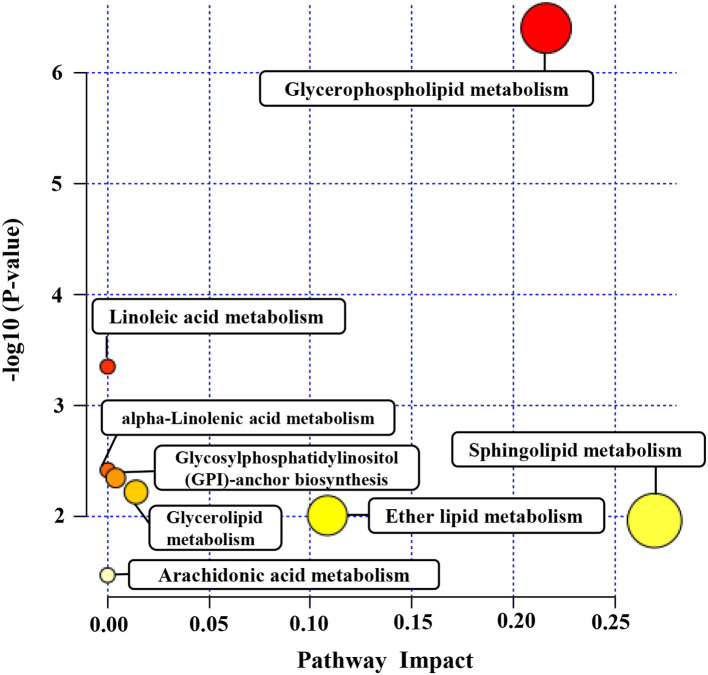
The metabolomic pathway of significantly different lipids analyzed by MetaboAnalyst. Pathway analysis of the significantly different lipids was carried out by MetaboAnalyst. The y axis represents the transformation of the original P-value calculated from the enrichment analysis. The x axis represents the value calculated from the pathway topology analysis.